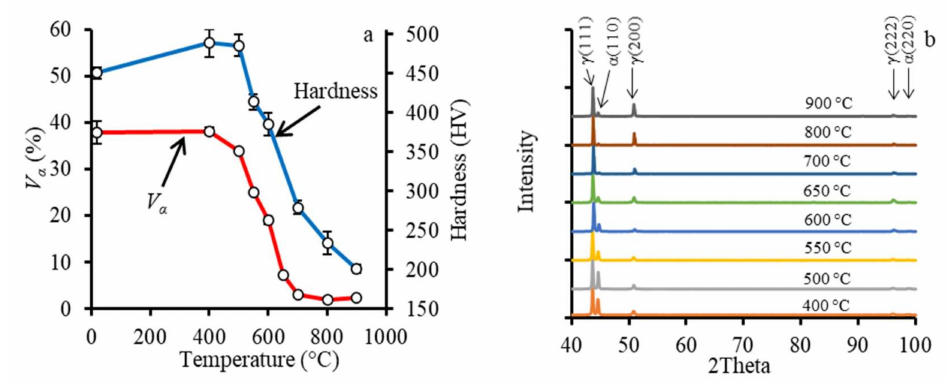
Figure 5. ( a ) Effect of annealing temperature on the α -phase content (V α , %) and hardness ( b ) XRD patterns of the as-processed program steel after